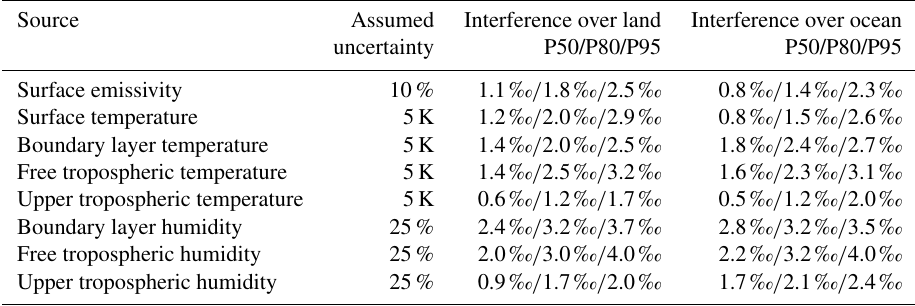
Table 1. Interferences in s sim ( 5km ) due to uncertainties in surface and atmospheric conditions. Listed are the 50, 80 and 95%-percentiles (P50, P80 and P95, respectively) for land and ocean